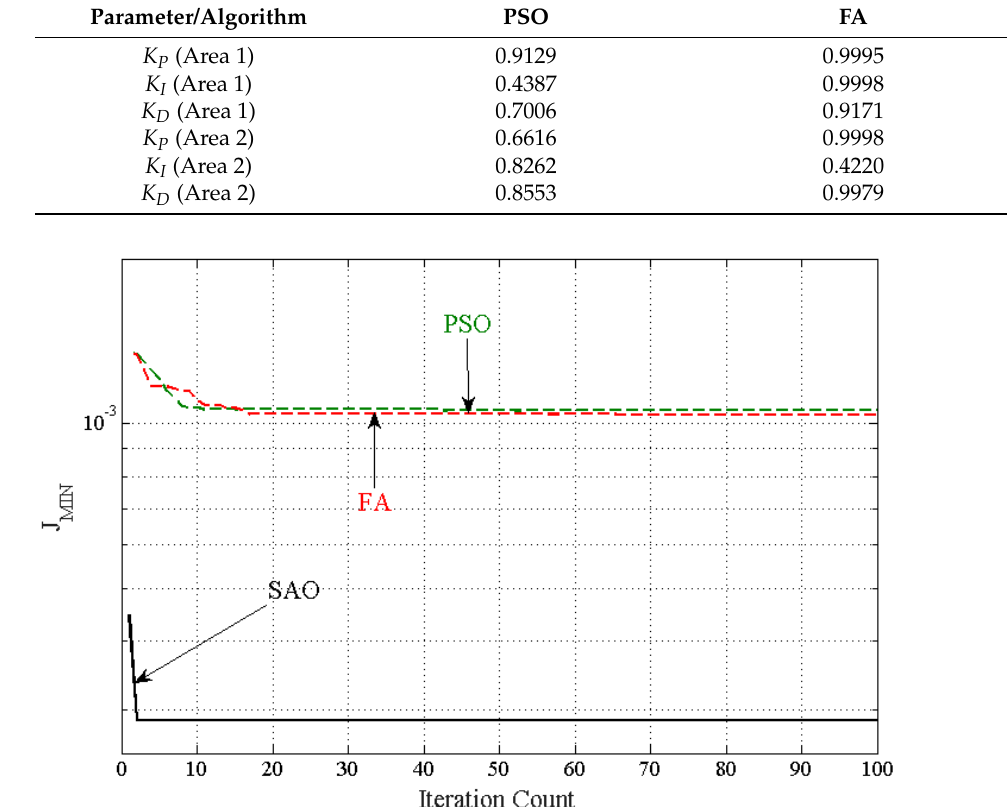
Figure 13. Convergence nature of PSO-PID, FA-PID, and SAO-PID controllers.